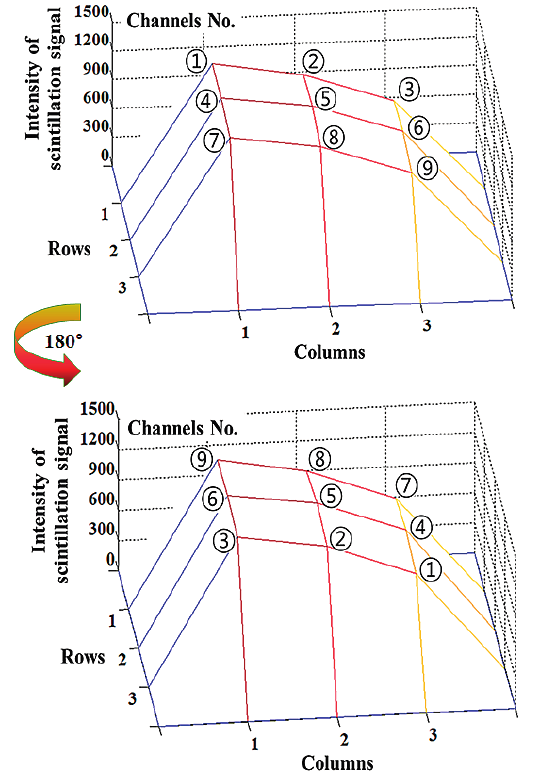
Figure 3. Intensity distribution of the scintillation signals measured by using the multichannel all-in-one phantom dosimeter when the phantom dosimeter was placed at 0° and 180° during beam irradiation with a tube potential of 150